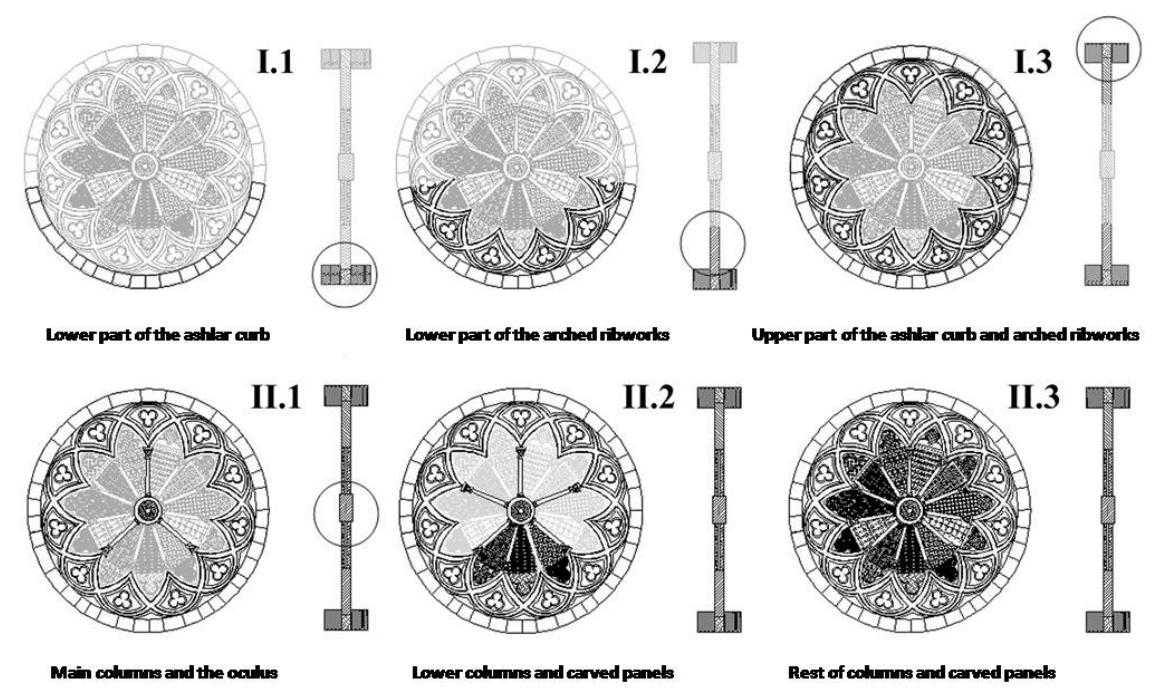
Fig. 6. Interpreted construction phases of the rose window of Troia Figure 6